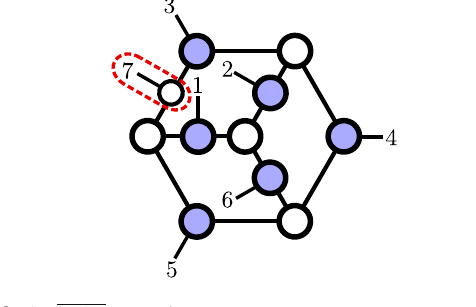
Fig. 3 An MHV example Table 2 Geometry constraints evolution for MHV example